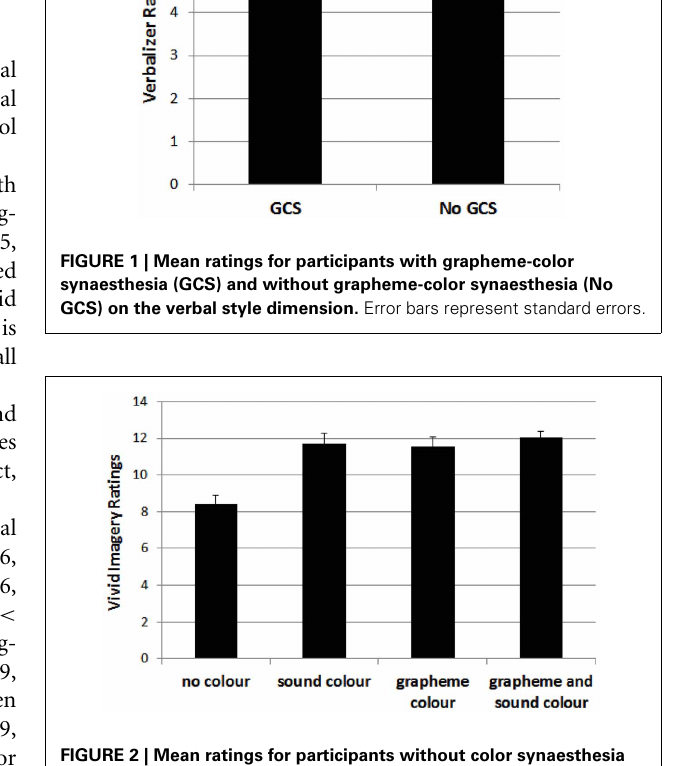
FIGURE 2 | Mean ratings for participants without color synaesthesia (no color) and those with color synaesthesia (i.e., sound-color, grapheme-color or both) on the vivid imagery style dimension. Error bars represent standard